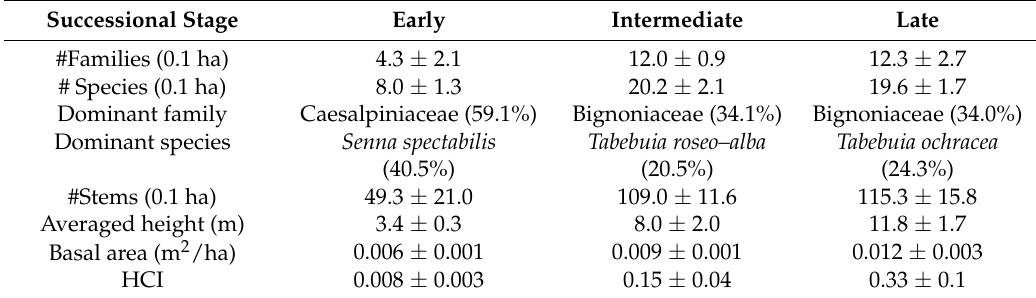
Table 1. Structure and composition of the successional stages of the TDFs in Mata-Seca